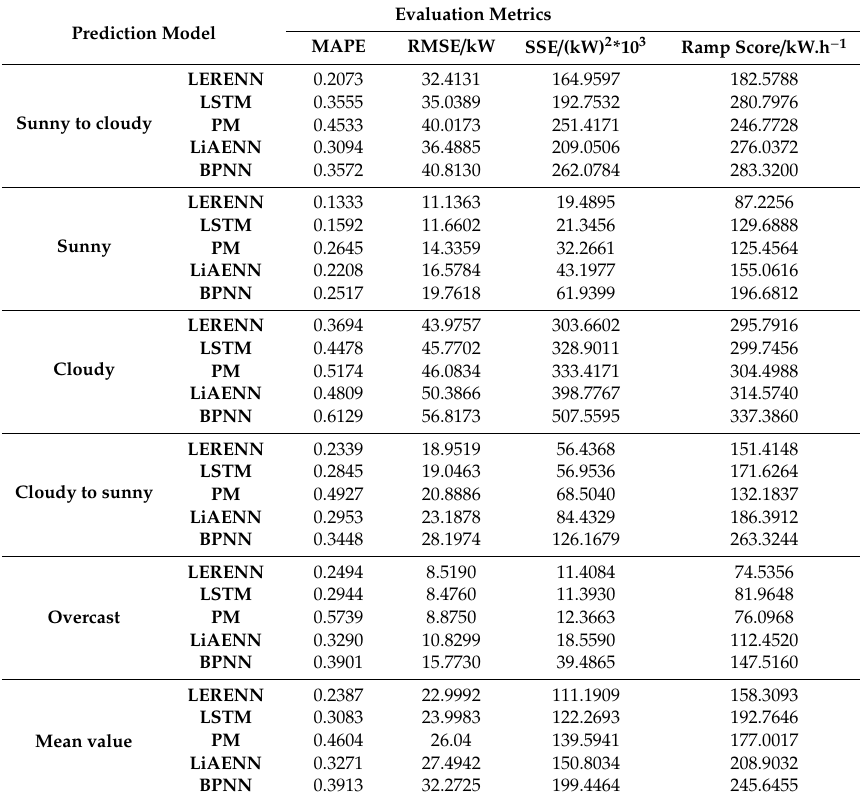
Figure 8. The distribution of each error interval for single-step prediction. Table 6. Comparison of three-step prediction errors among di ff erent models under di ff erent weather